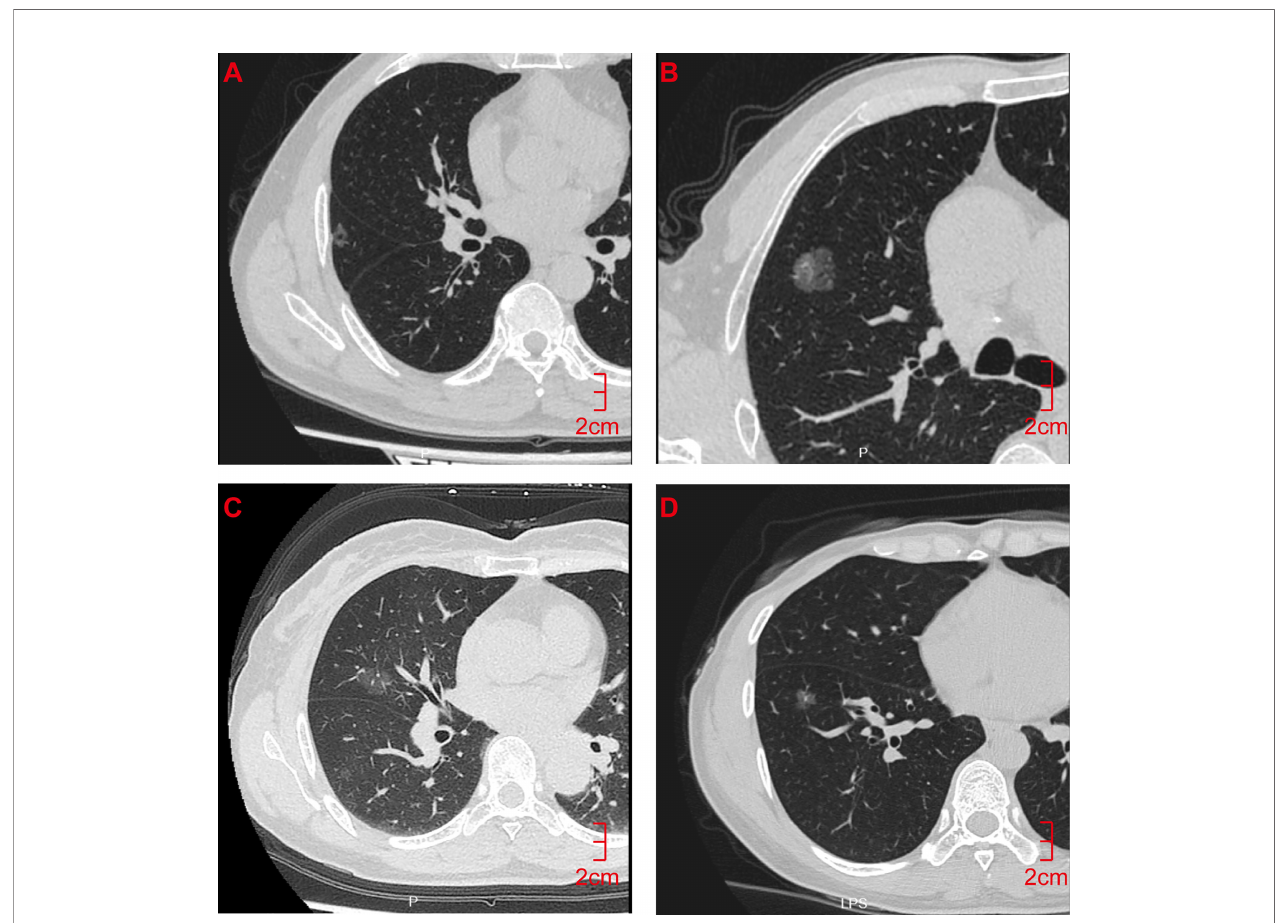
FIGURE 2 | CT Findings of representative IAC and MIA nodules. (A) M/55y, pGGN of the right upper lobe with a long diameter of 1.2 cm, pathological diagnosis showed that the lesion was IAC. (B) M/32y, mGGN of the right upper lobe with a long diameter of 1.5 cm, pathological diagnosis showed that the lesion was IAC. (C) F/62y, pGGN with a long diameter of 1.2 cm in the right middle lobe, pathological diagnosis showed that the lesion was MIA. (D) F/55y, pGGN with a long diameter of 1.0 cm in the right lower lobe, pathological diagnosis showed that the lesion was MIA. CT, computed tomography; pGGN, pure ground-glass nodule; mGGN, mixed ground-glass nodules; IAC, invasive adenocarcinoma; MIA, minimally invasive